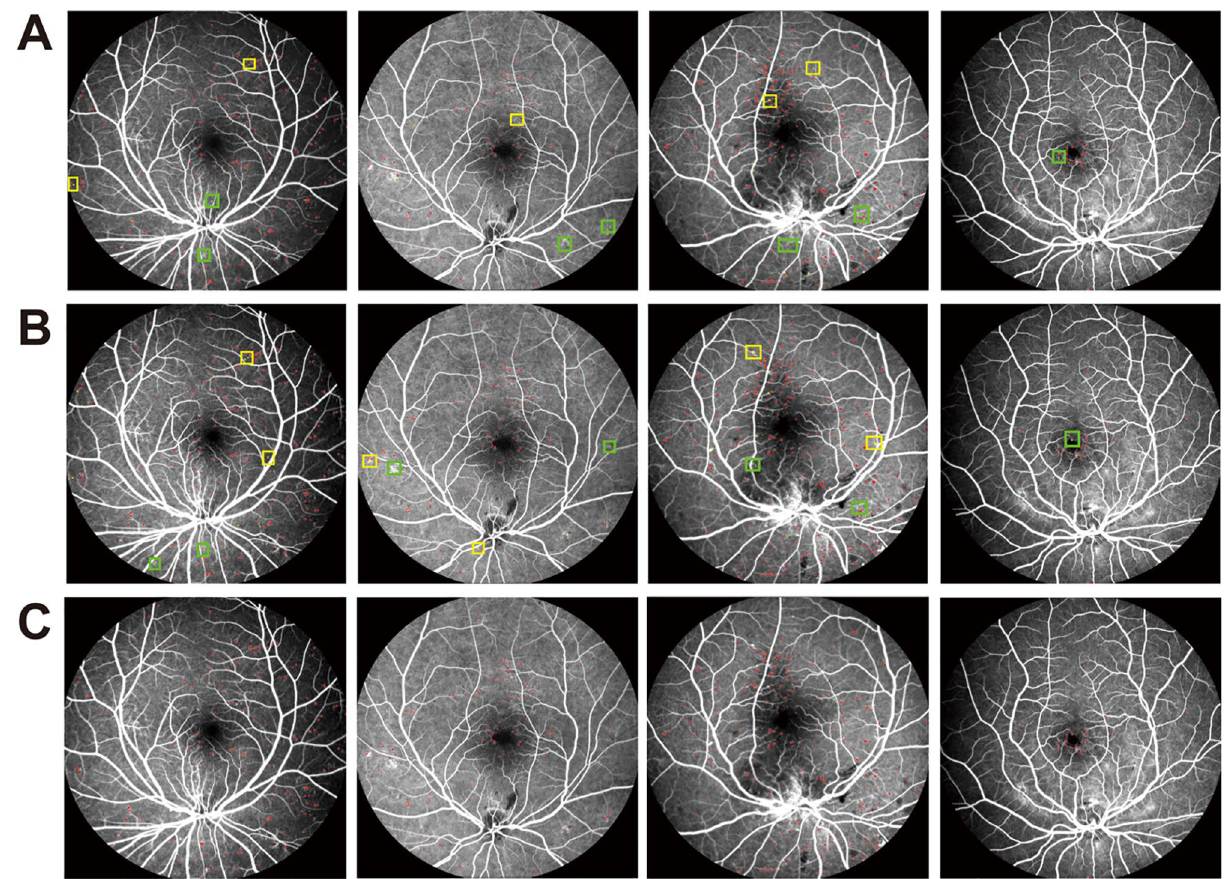
Figure 5. MA detection results by FC-DenseNet56, FC-DenseNet67, and MAs-FC-DenseNet. ( A ) FC-DenseNet56; ( B ) FC-DenseNet67; ( C ) MAs-FC-DenseNet.